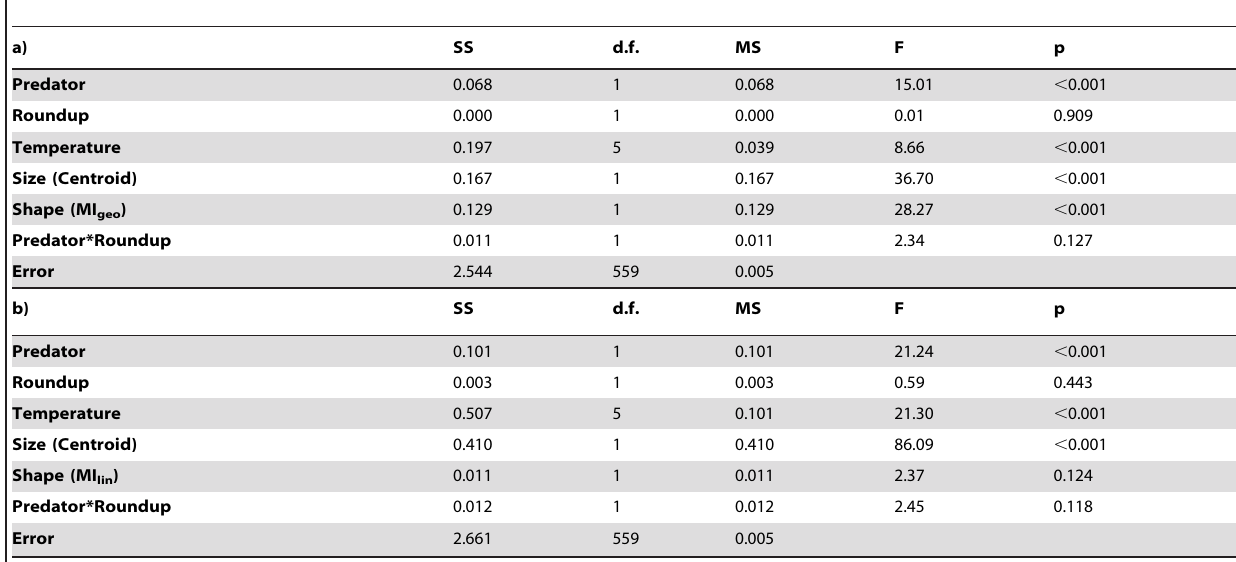
Table 7. ANCOVA analysis using burst speed as dependent variable, shape variables MI geo (a) or MI lin (b) and tadpole size (centroid) as continuous predictors, alongside temperature, predator cues and Roundup as categorical predictors.